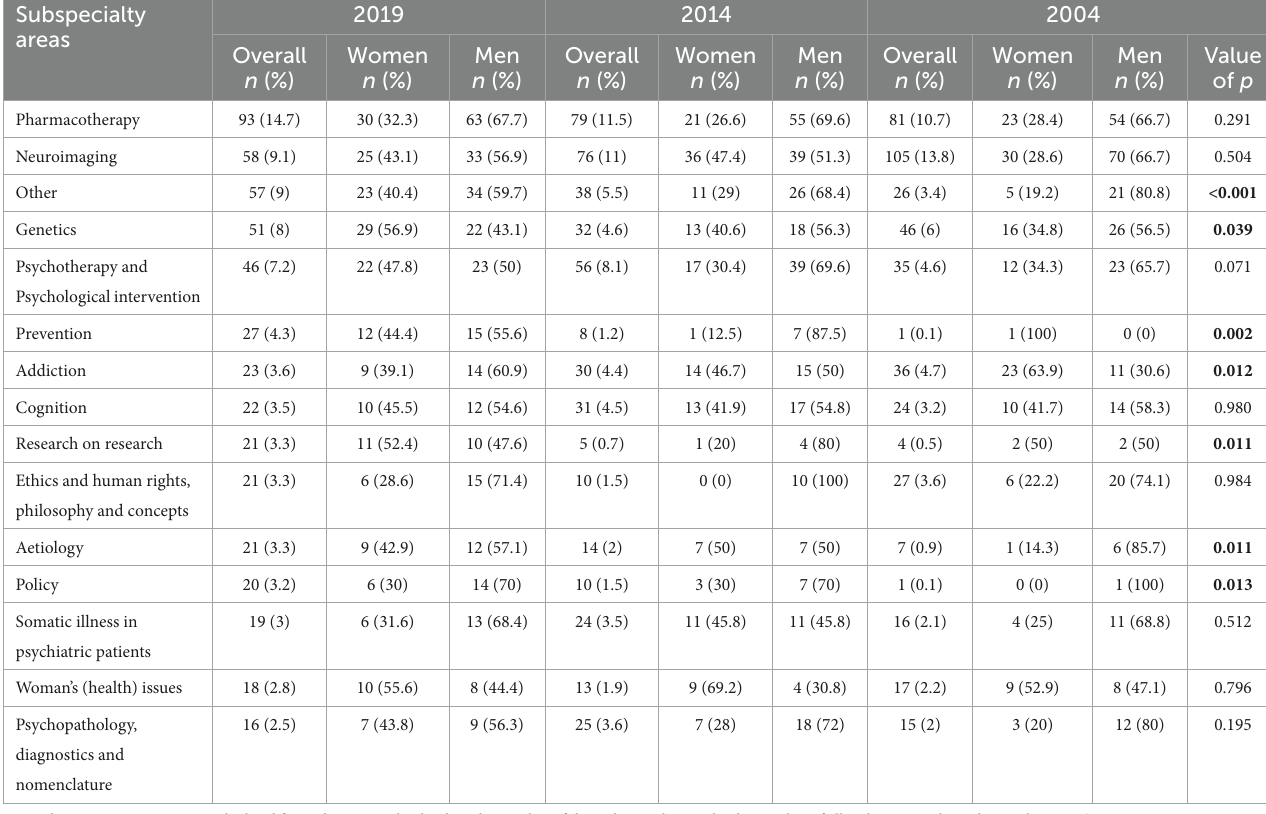
TABLE 2 Number of articles and number of female and male first authors of articles by subspecialty area in 2004, 2014 and 2019. Subspecialty